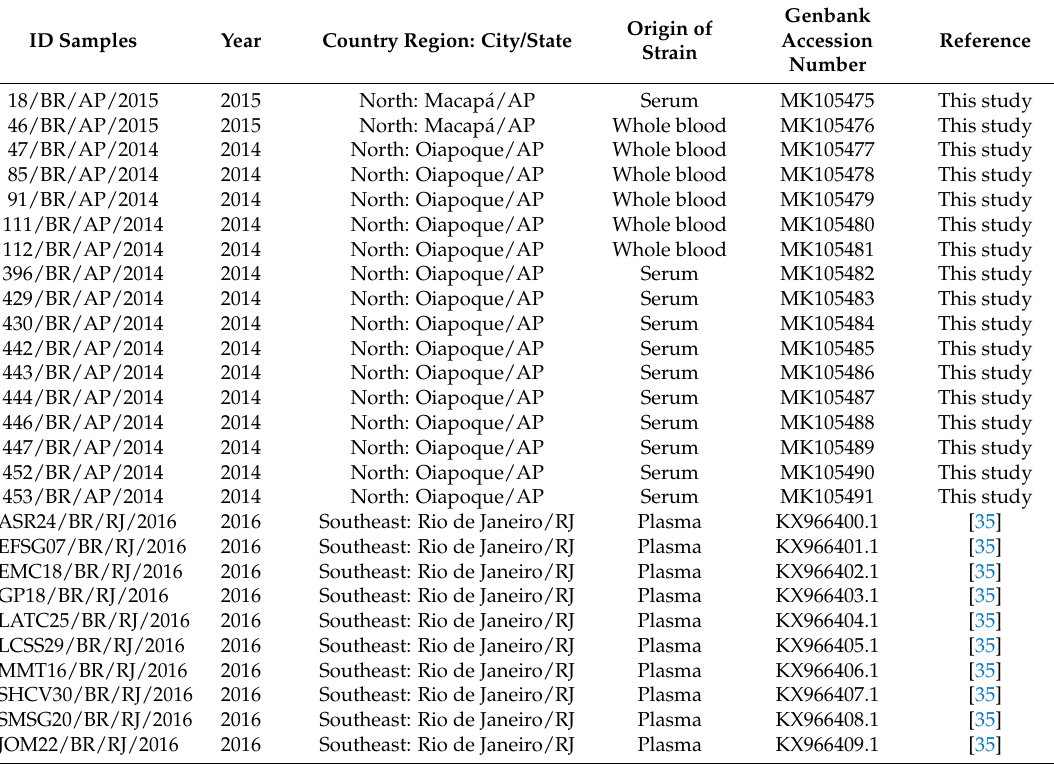
Table 4. The CHIKV strains from Amap á ( n = 17) and Rio de Janeiro ( n = 10) used in this study for partial E1 gene (375 nucleotides) sequencing, 2014 to 2016,